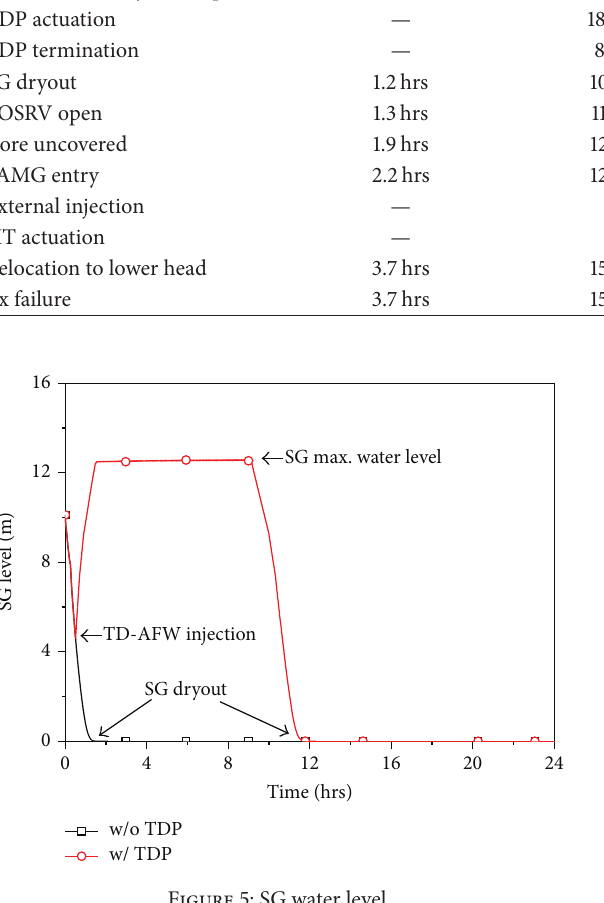
Figure 6: Core exit and fuel